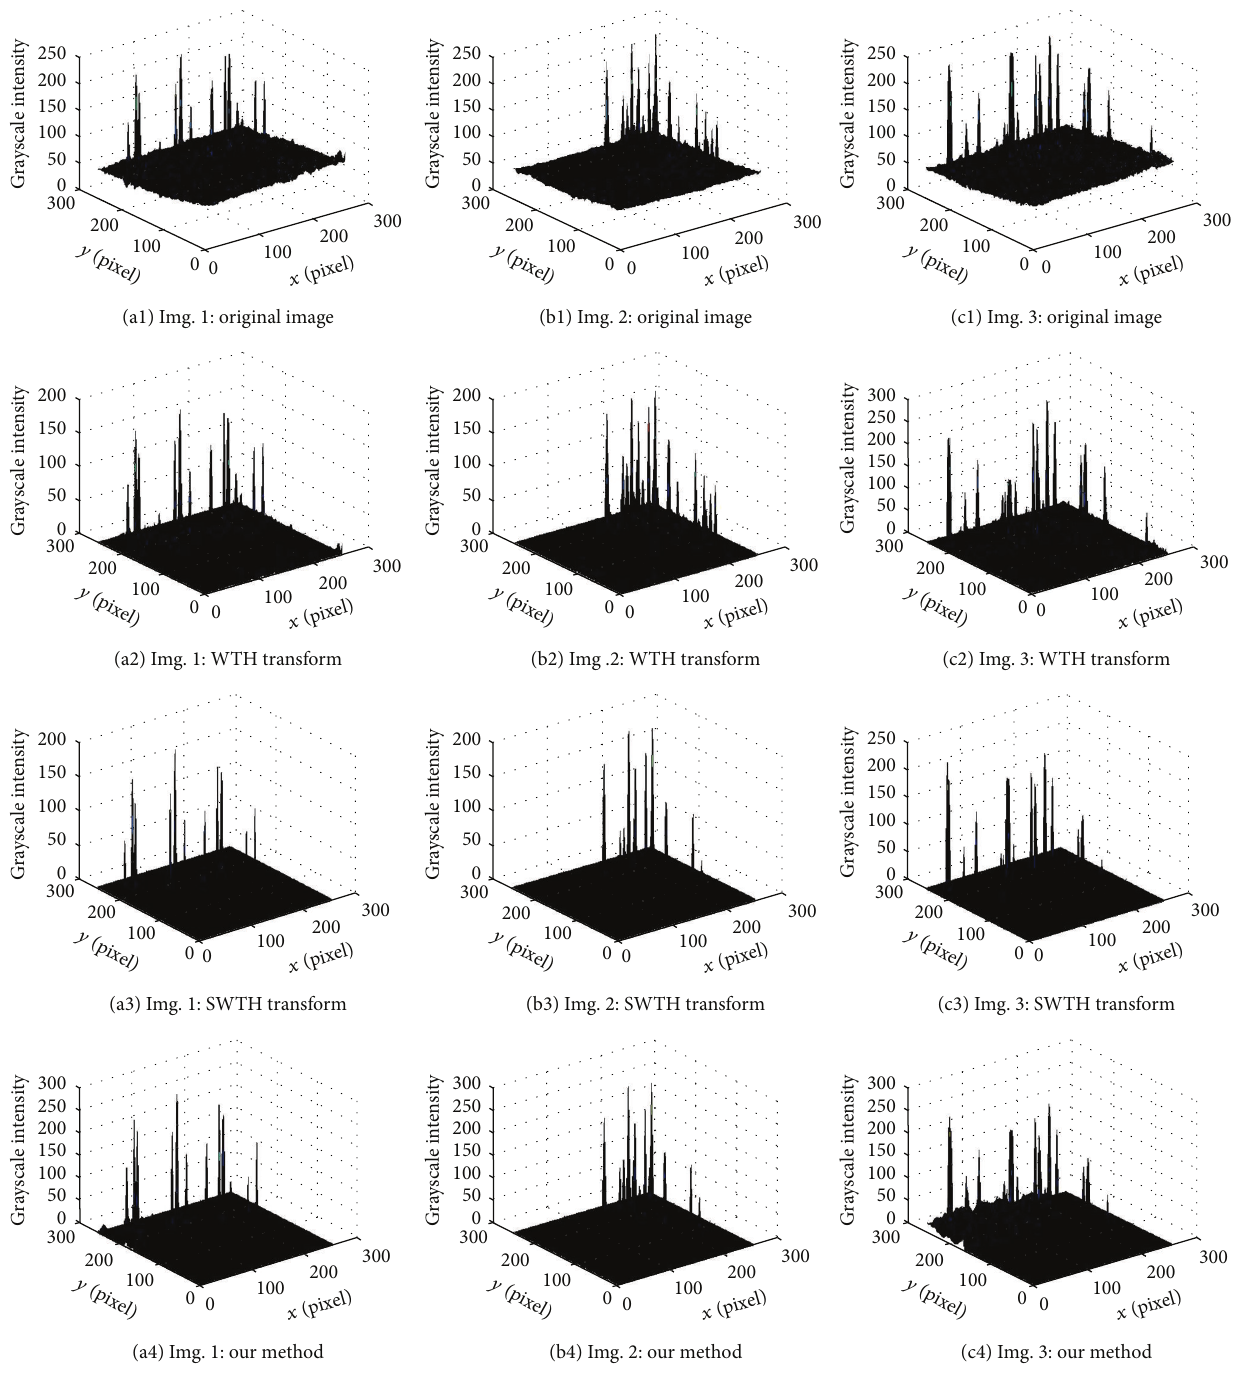
Figure 8: Comparison of three methods on 3D grayscale distribution